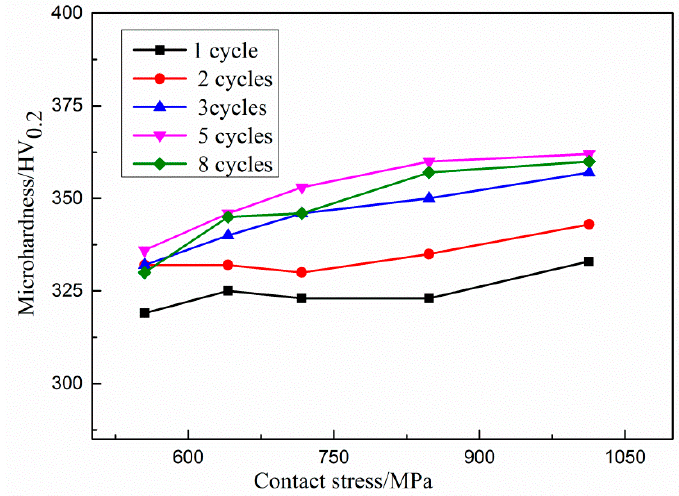
Figure 7. Influence of contact stress on rolled surface microhardness.